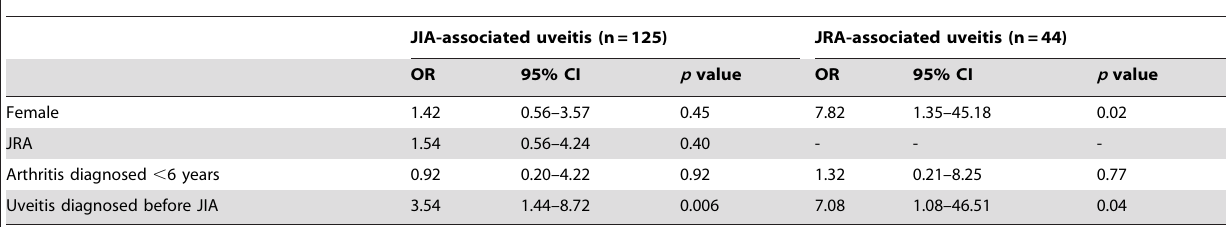
Table 2. Risk factors for complications of glaucoma or cataract in uveitis